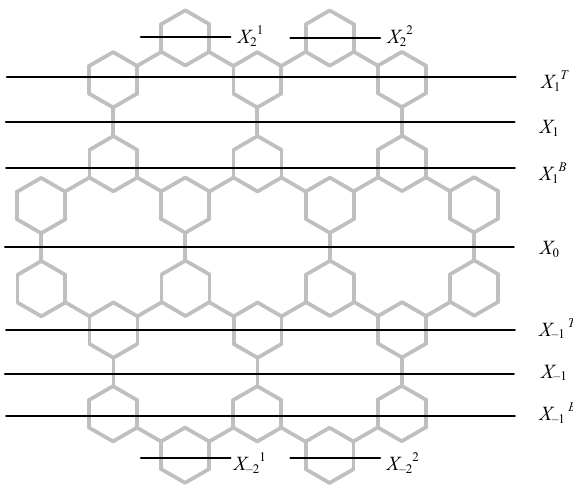
Figure 3: Various edge cuts made up of edges perpendicular to X